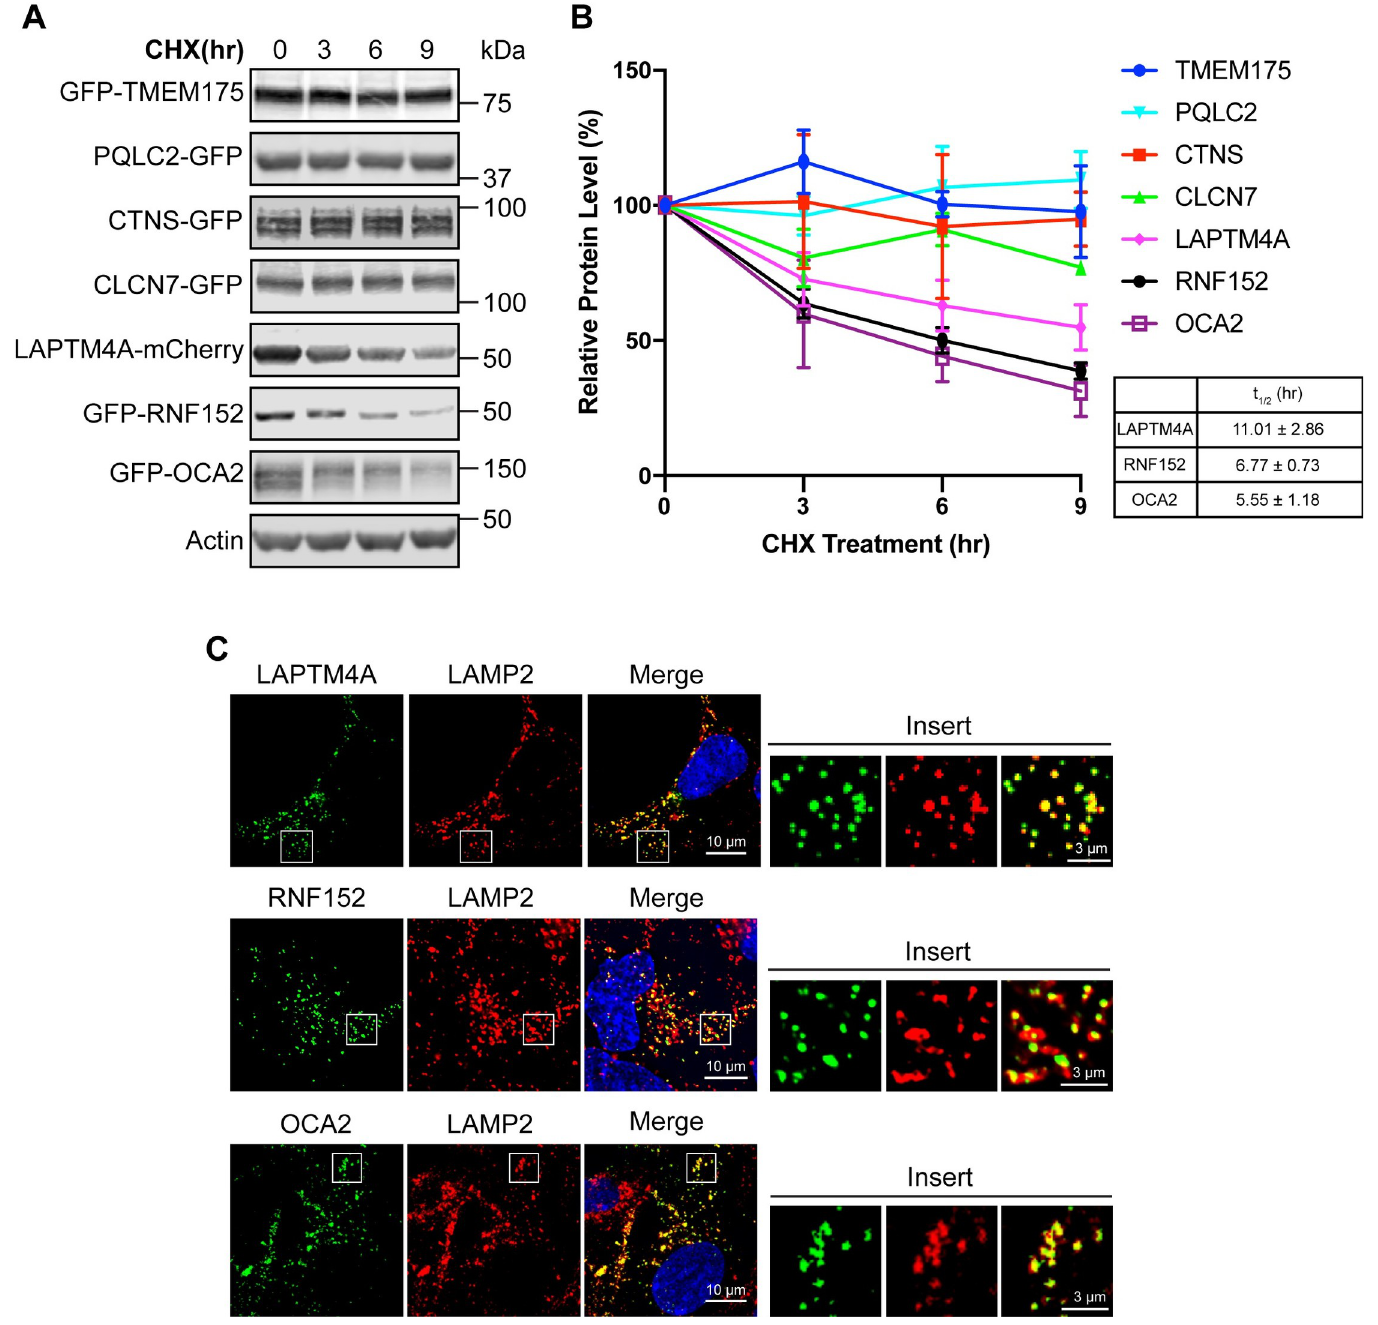
Fig 1. CHX chase assay to determine the stability of LMPs. (A) CHX chase assay to determine the stability of transiently expressed LMPs in HEK293 cells. (B) Quantification of the protein levels in A, n = 3. Error bars represent standard deviation. The half-lives (t 1/2 ) of LAPTM4A, RNF152, and OCA2 were listed in the table. (C) Immunofluorescence showing the localization of LAPTM4A-mCherry, GFP-RNF152, and GFP-OCA2 in HEK293 cells co-stained with LAMP2. Uncropped western blots and microscopy images are provided in S1 Raw Images. The numerical data underlying the plot can be found in S1 Data. CHX, cycloheximide; LAMP2, lysosome- associated membrane protein 2; LMP, lysosomal membrane